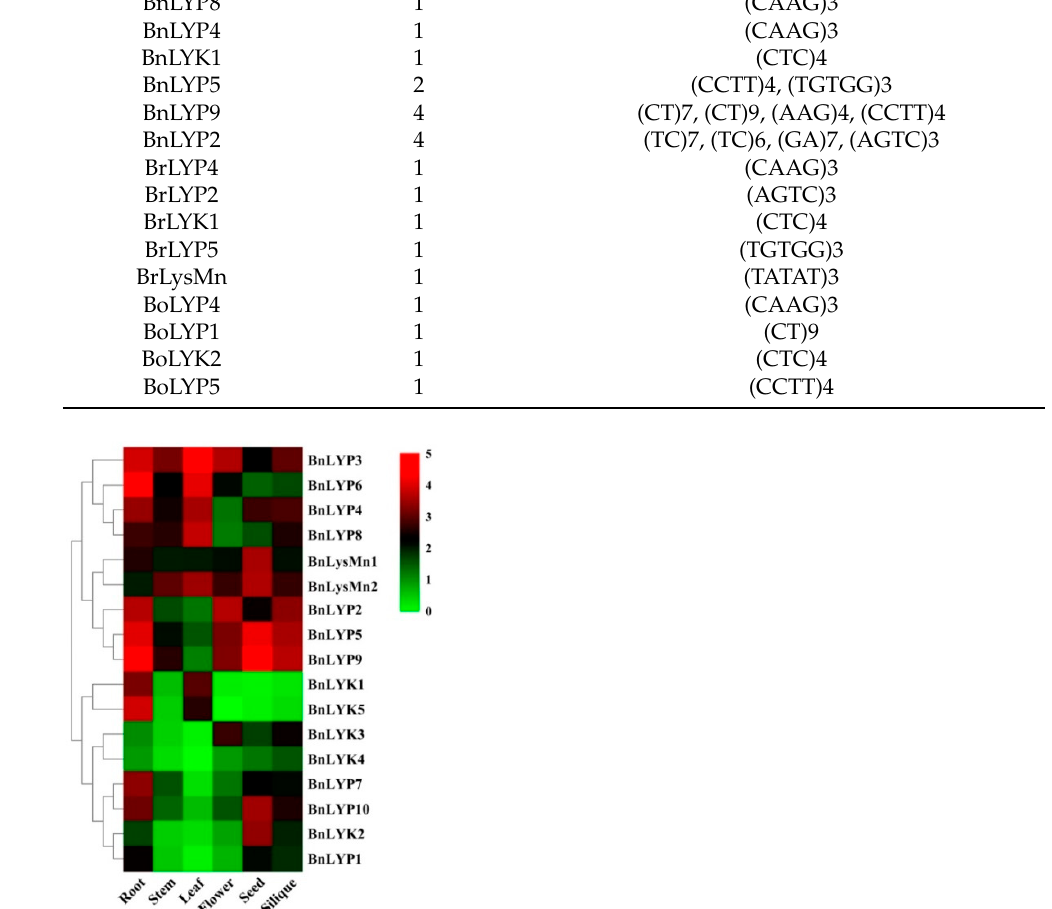
Figure 4. The expression pattern of LysM-RLK genes in different tissues. The color boxes indicate expression values, the lowest (green), medium (black), and the highest (red).